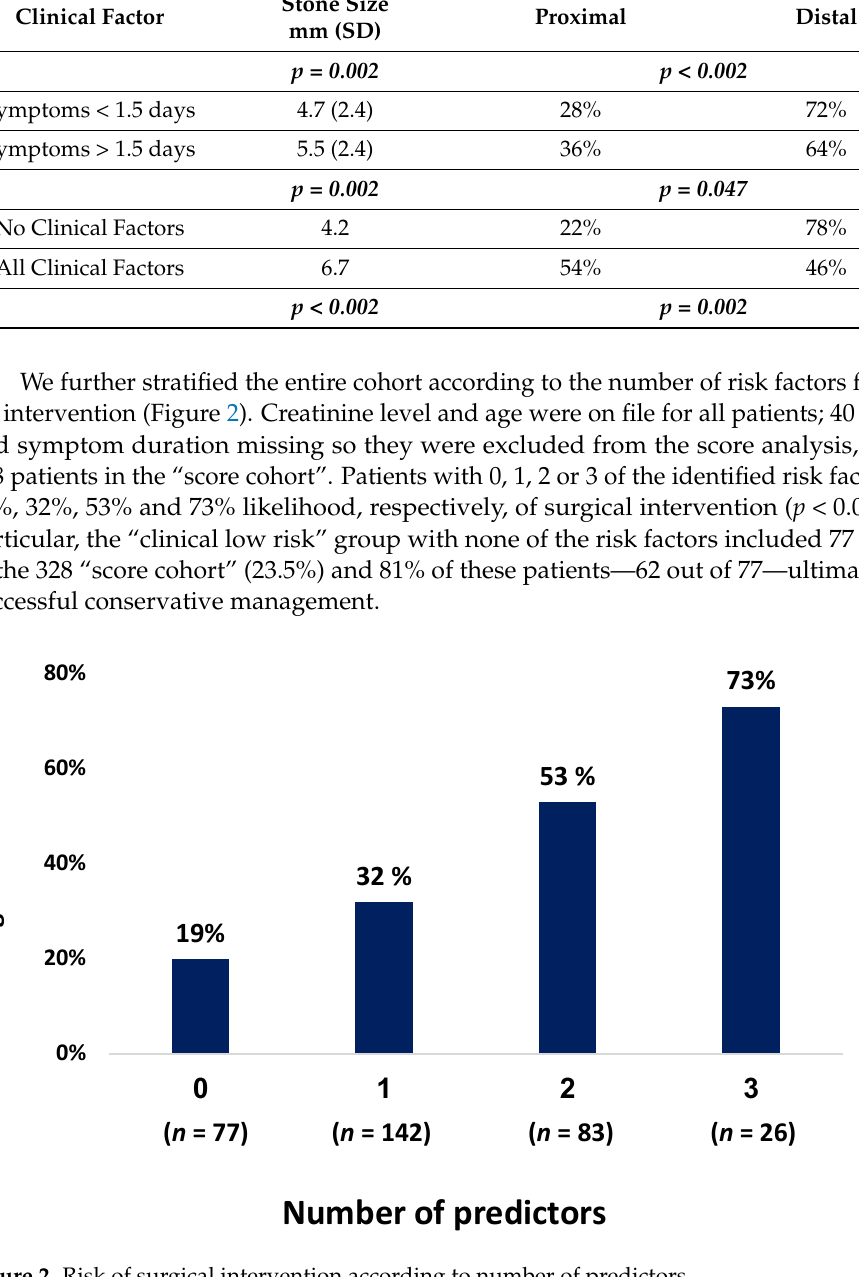
Figure 2. Risk of surgical intervention according to number of predictors.